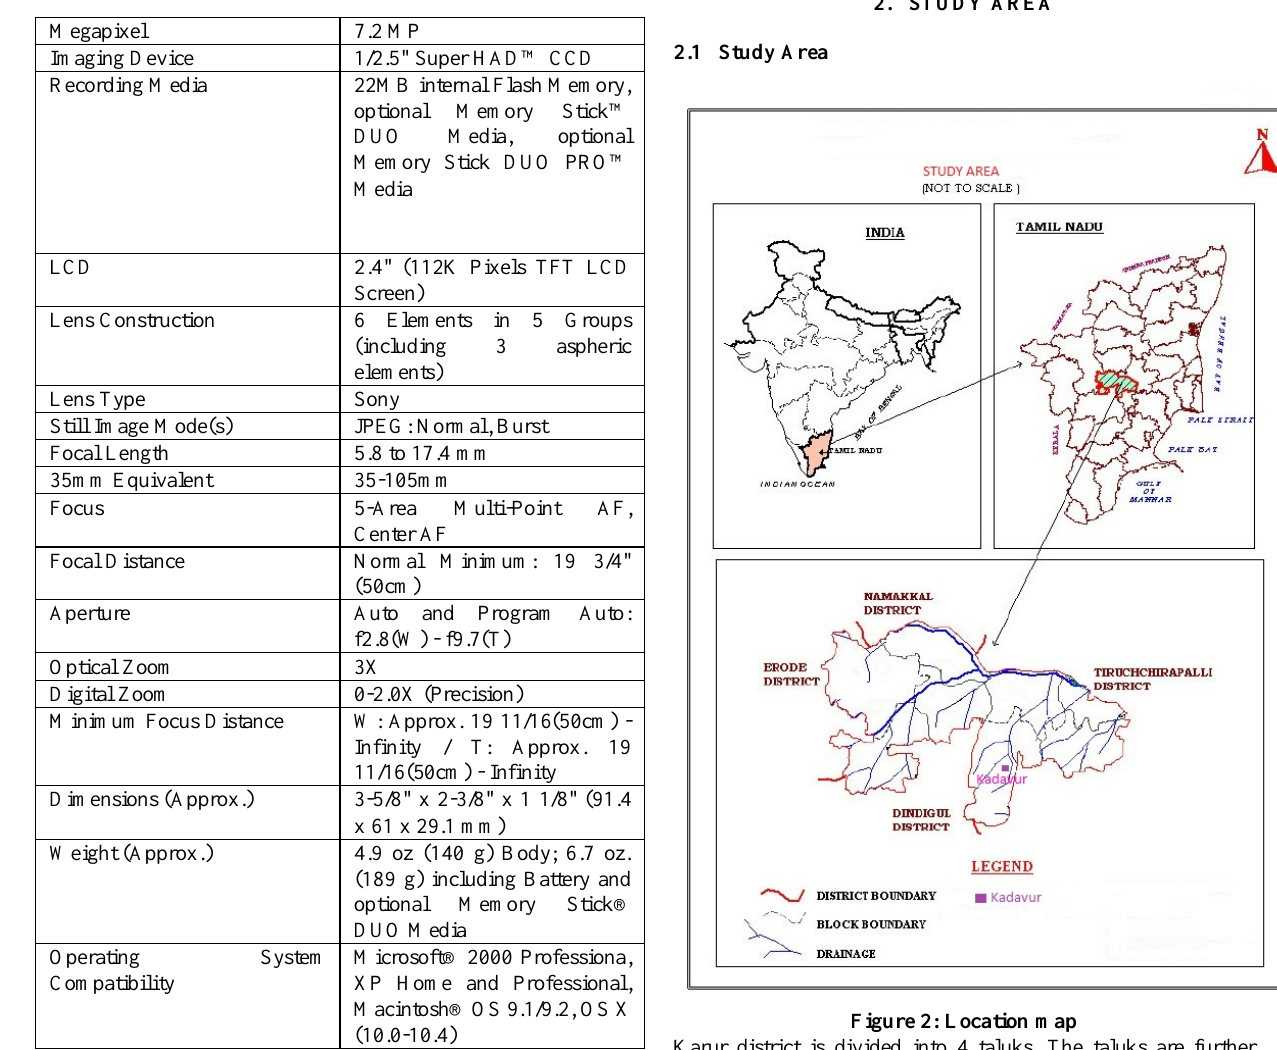
Table 2: Technical Specifications of SONY DSC S730